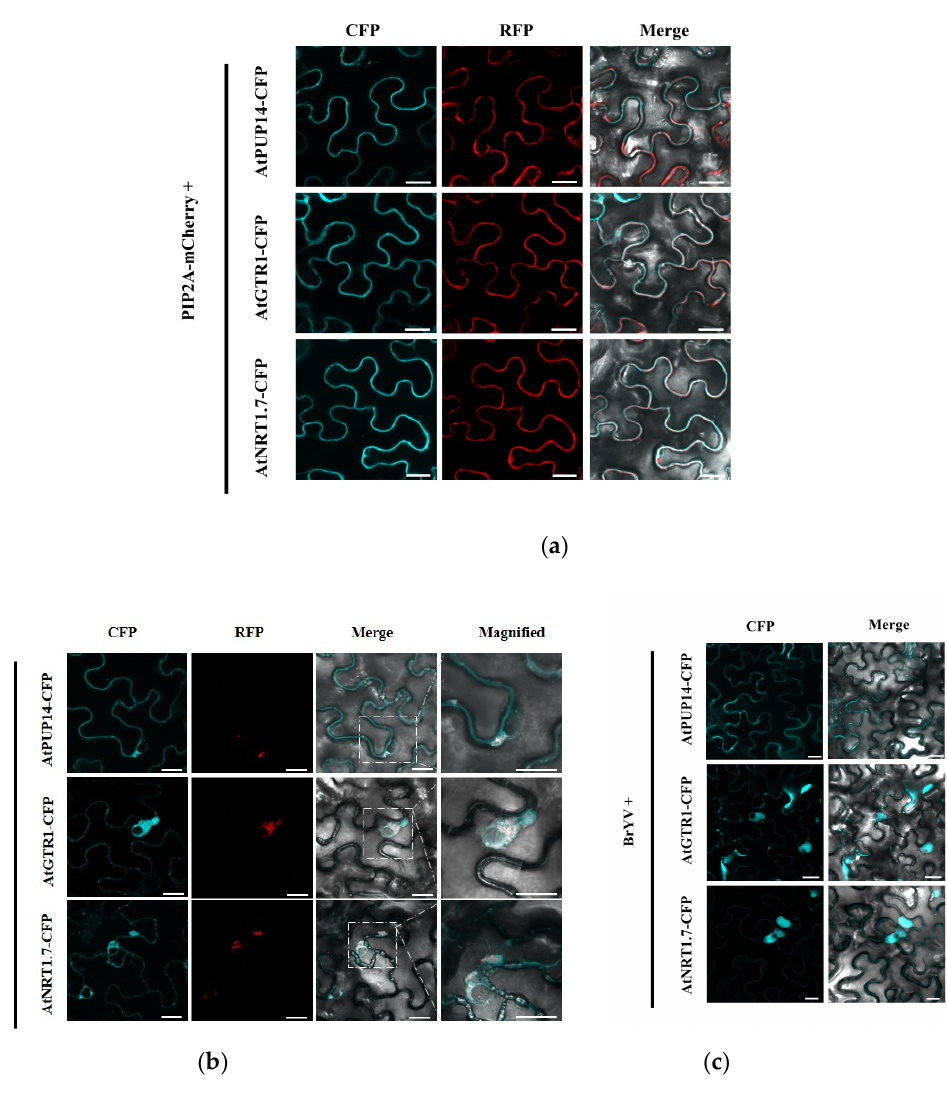
Figure 3. Subcellular localization of P3a interacting proteins during P3a expression and BrYV infection. ( a ) Co-localization of P3a and PIP2A-mCherry. PIP2A acts as a PM marker; ( b ) Co-localization of P3a and its interacting proteins. AtPUP14-CFP, AtGTR1-CFP, and AtNRT1.7-CFP were co-expressed with P3a-RFP in N. benthamiana leaves; ( c ) Subcellular localizations of AtPUP14-CFP, AtGTR1-CFP, and AtNRT1.7-CFP during BrYV infection; confocal analyses were conducted at 2 dpi. Scale bars = 20 μM.